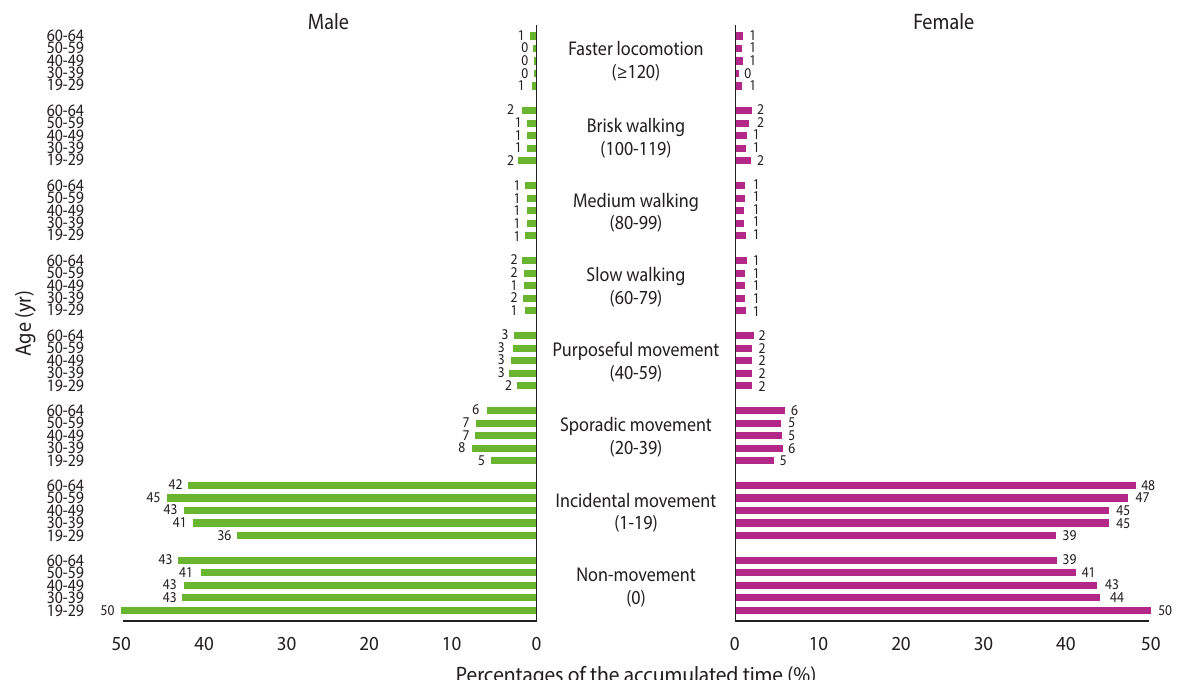
(right).Percentages of the accumulated time Figure 1. The percentage of time spent in each cadence category (unit: steps/min) across age groups by sex. The percentage of cumulative time in each cadence across age groups in male (left) and female